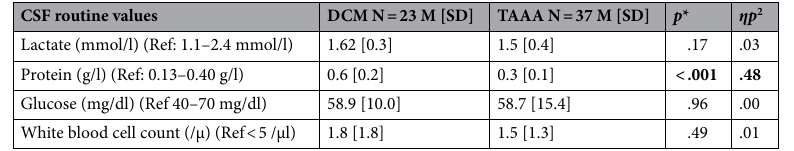
Table 2. CSF routine values of patients (DCM) and controls (TAAA). CSF cerebrospinal fluid, DCM degenerative cervical myelopathy, TAAA thoracic-abdominal aortic aneurysm , M = mean , SD = standard size. Bold values indicate significance level of p < .05.